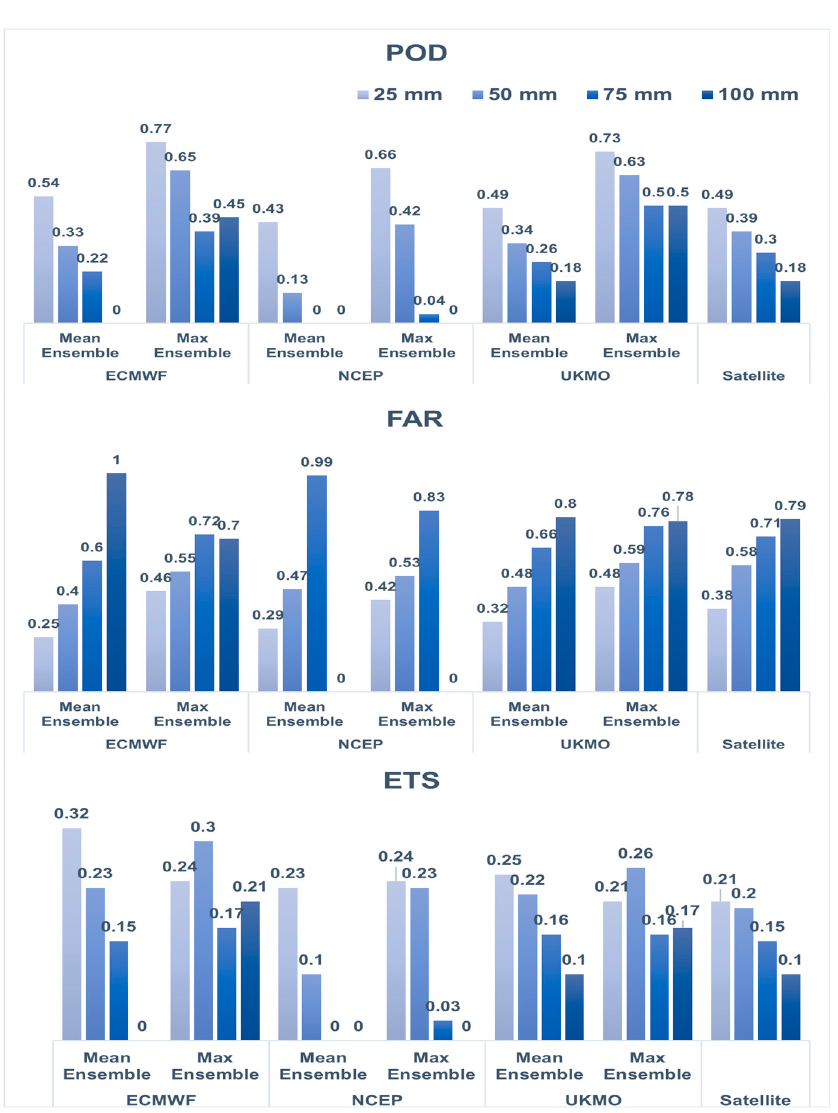
Figure 9. Verification statistics (POD, FAR, and ETS) between ECMWF, NCEP, UKMO, IMERG, and the in situ observations for different thresholds over Iran for 15 March 2019 to 2 April 2019.